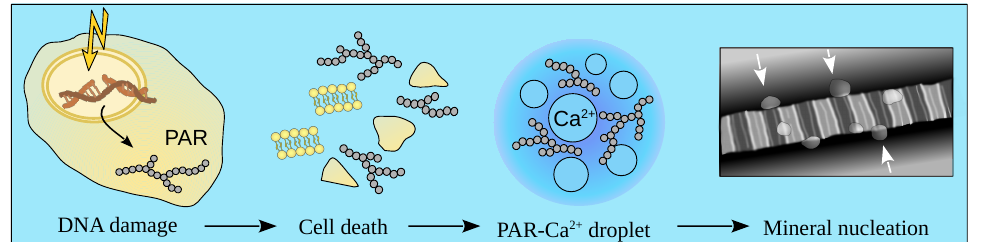
Figure 2. PAR and bone mineralization. Oxidative damage in differentiating osteoblasts triggers PARP1 overactivation inducing cellular necrosis and delivering PAR to the extracellular matrix. PAR forms dense liquid droplets with Ca 2 + ions that bind to the surface of collagen fibrils, thus initiating the nucleation of mineral platelets